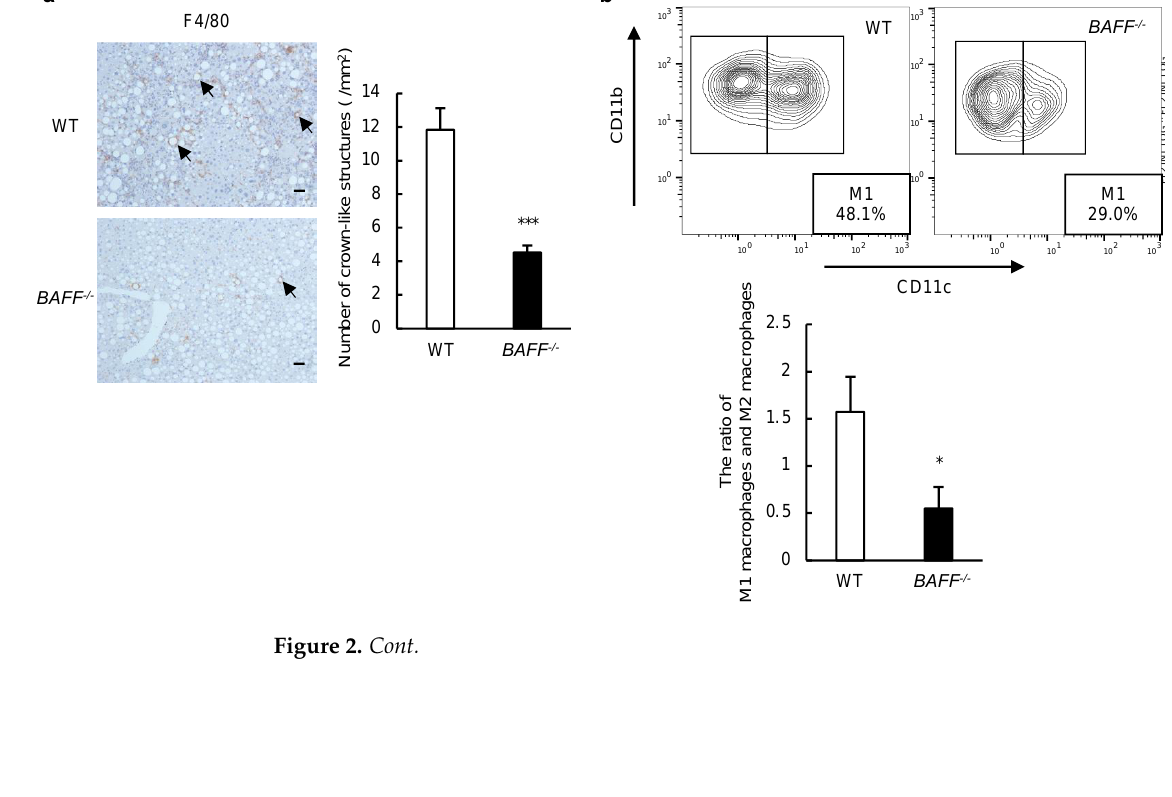
Figure 2. Liver inflammation is attenuated in BAFF −/− mice in murine models of NASH. ( a ) Repre- sentative F4/80 staining of the liver from HFHCD/CCl 4 -treated WT and BAFF −/− mice (left). The ar- rows point to the CLSs formed by macrophage aggregation. Quantitative measurement of CLSs (right) (scale bar, 100 μm; images from six different fields; n = 8/group); ( b ) Representative flow cytometry contour plots showing frequencies of F4/80 + CD11b + CD11c + cells (M1 macrophages) among liver NPCs isolated from liver from HFHCD/CCl 4 -treated WT and BAFF −/− mice (upper). The ratio of quantification of M1 macrophages and F4/80 + CD11b + CD11c − cells (M2 macrophages) iso- lated from liver NPCs (lower) ( n = 7/group); ( c ) Relative mRNA levels of the indicated genes in the liver from HFHCD/CCl 4 -treated WT and BAFF −/− mice ( n = 10 – 15/group); ( d ) Representative iNOS and F4/80 staining (upper) and quantification of the iNOS-positive area (lower) of liver from with HFHCD/CCl 4 -treated mice. The iNOS-positive macrophages were detected as reddish and dark blu- ish (scale bar, 100 μm; images from seven d ifferent fields; n = 5/group). For all bar plots shown, data